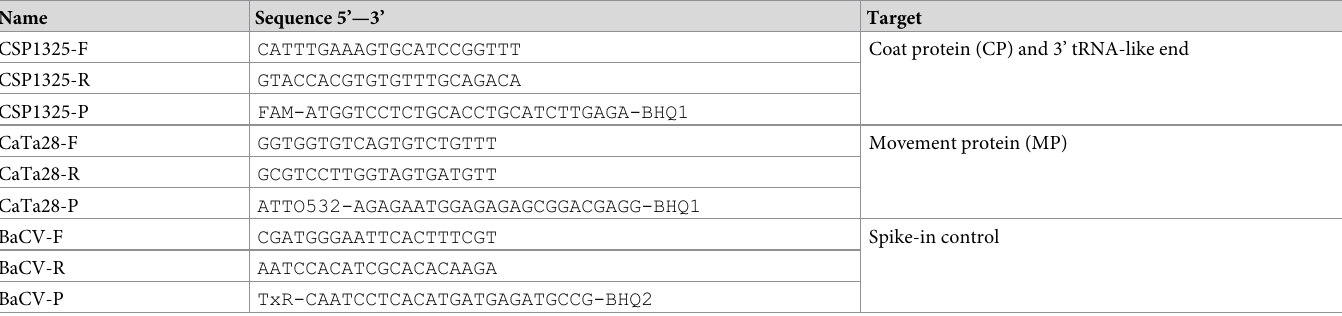
Table 1. Oligonucleotides described in the ToBRFV ISHI-Veg protocol [26] used in this